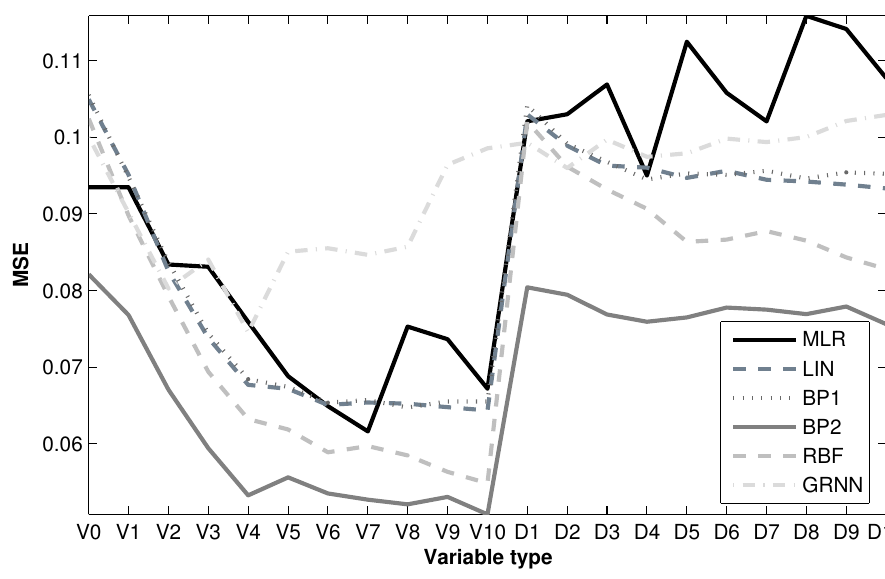
Figure 10. Evolution of the performance of the